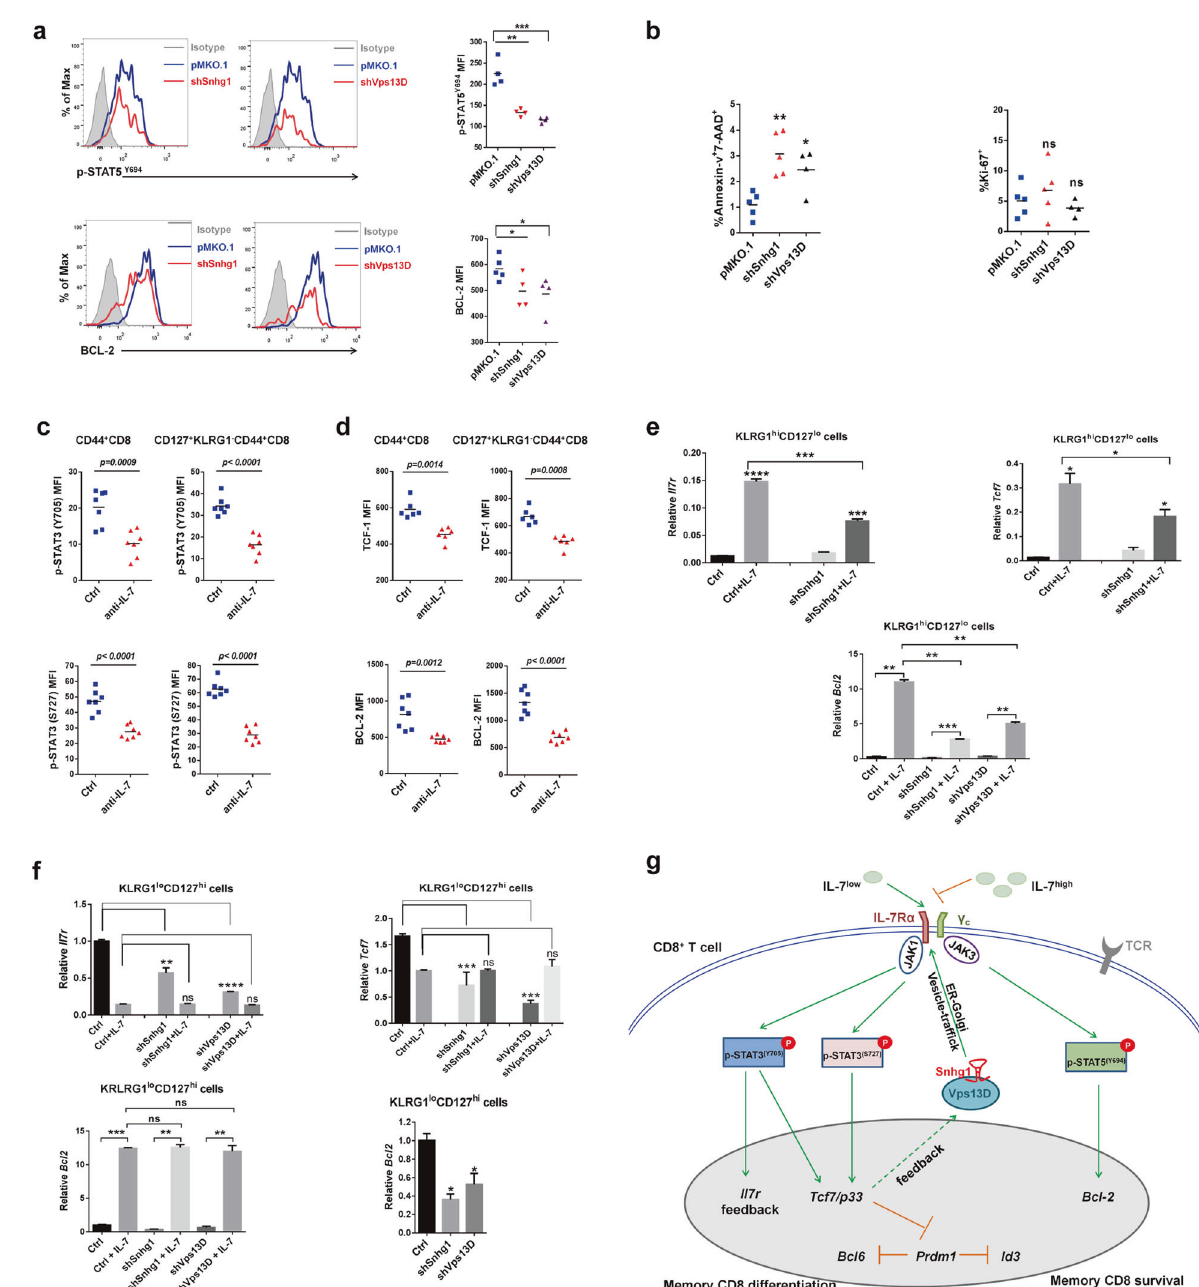
Fig. 7 The dual-function and dose-effect of Snhg1-Vps13D regulated IL-7 signaling in memory CD8 T cell establishment. a Mean fl uorescence intensity of p-STAT5 Y694 and BCL-2 in control or sh Snhg1 /sh Vps13D GFP + P14 cells on day 45 p.i. b The proportion of Annexin-v + 7-AAD + and Ki-67 + cells in GFP + P14 cells on day 40 p.i. c , d C57 mice were injected (i.v.) with PBS or 100 ug anti-IL-7 mAb at 2 days intervals since day 8 p.i., MFI of p-STAT3 (Y705/S727)/TCF-1/BCL-2 in bulk memory (left) for memory T cells (right) were analyzed on day 15 p.i. e – f The sorted CD127 hi or CD127 lo cells from pMKO.1/sh Snhg1 /sh Vps13D groups on day 8 p.i. were treated with PBS or 5 ng/ml IL-7 for 48 h culturing in vitro followed by RT-qPCR analysis of Il7r/Tcf7/Bcl2 . g A model to show the dual-function and dose-effect of Snhg1-Vps13D regulated IL-7 signaling in memory CD8 T cell